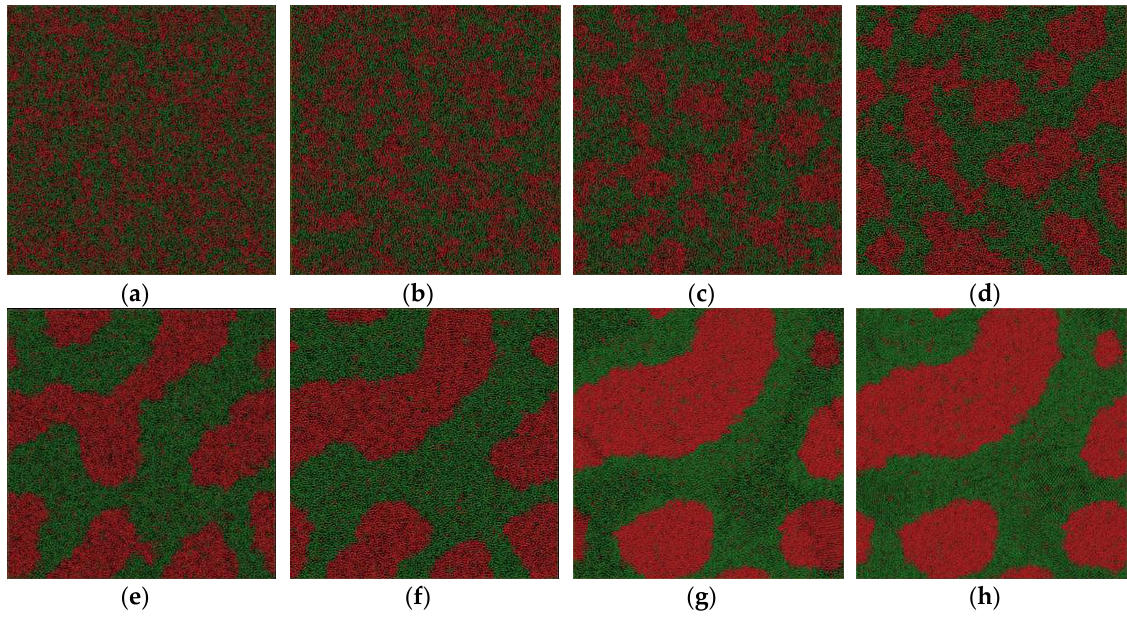
Figure 6. Atom snapshot of Fe 50 Cu 50 at different temperatures at the cooling rate of 1.28 × 10 11 K/s. ( a – h ) correspond to the atomic configuration at temperature of 2000 K, 1800 K, 1600 K, 1400 K, 1200 K, 1100 K, 1000 K, 800 K, respectively.